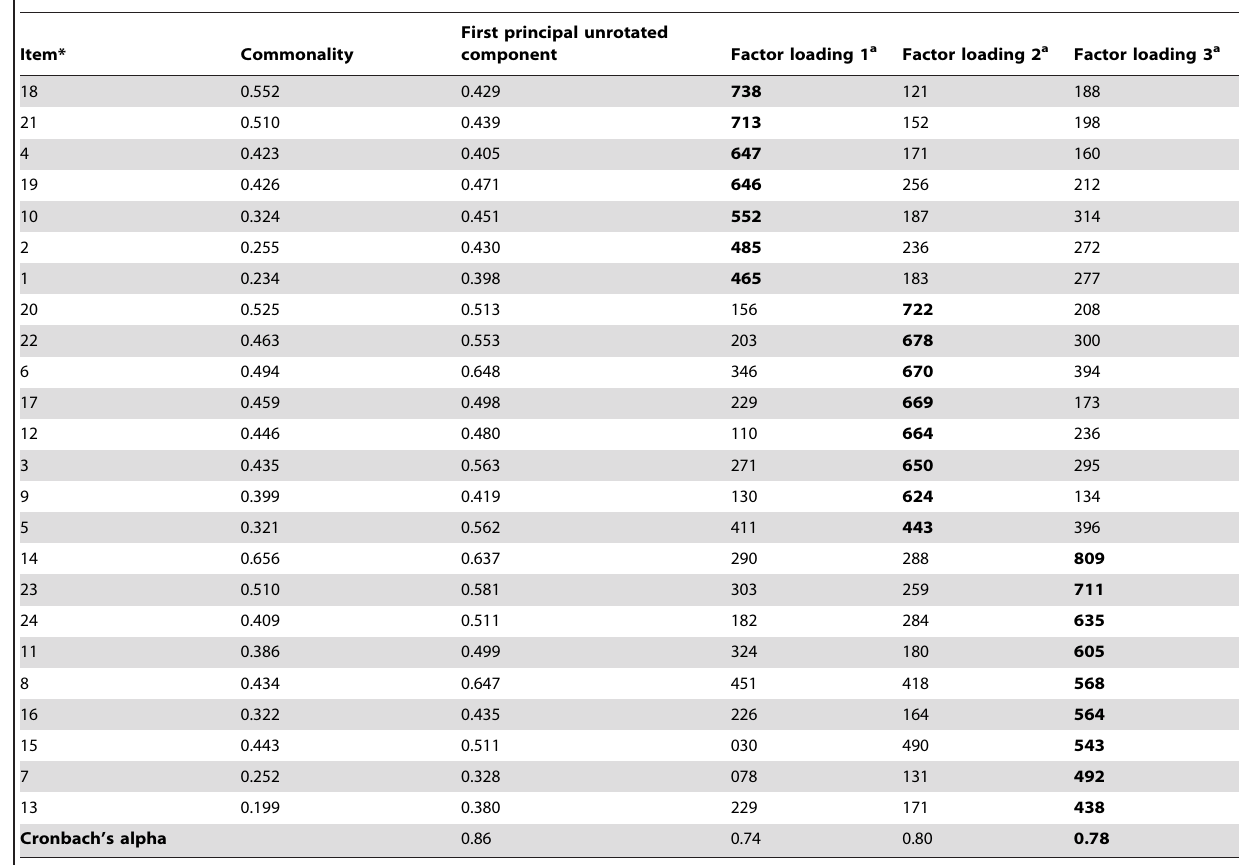
Table 3. Principal components analysis with oblimin rotation of the AAQ.